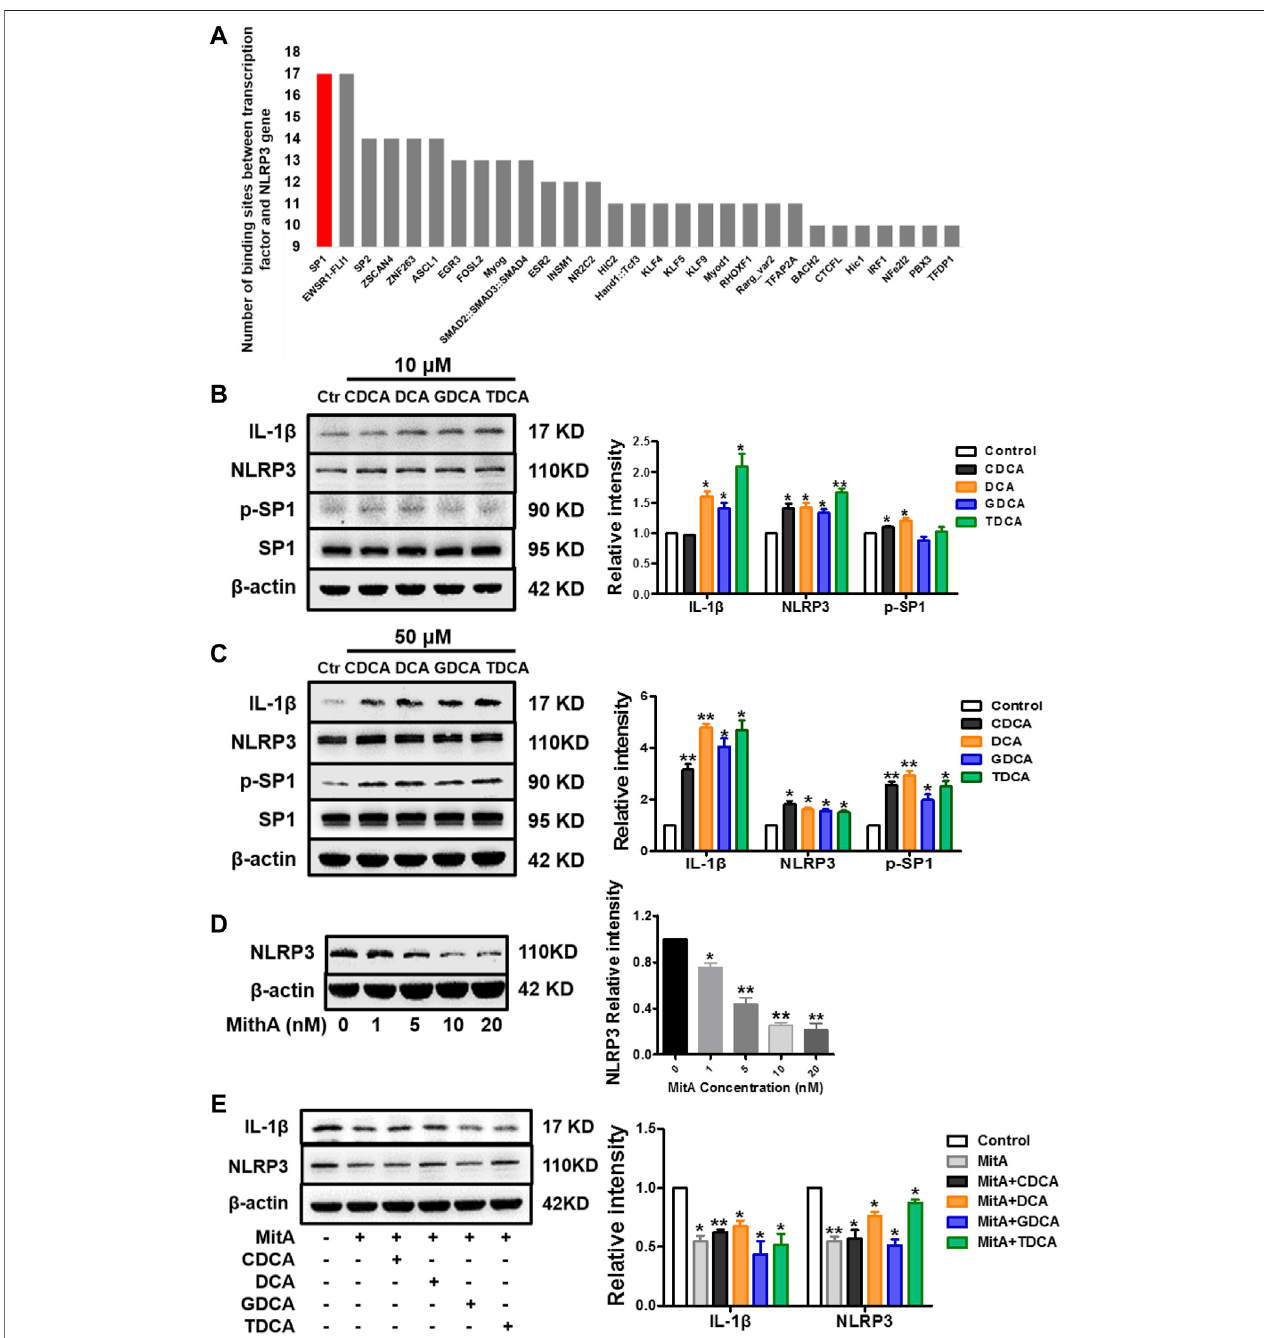
FIGURE 3 | SP1 mediates the activation of NLRP3 in fl ammasome in non-in fl ammatory conditions in macrophages. (A) Ranking of binding sites between different transcriptionfactors andNLRP3gene(datawerefromtheeukaryoticpromoterdatabase,from − 2,000to100 bprelativetoTSS,andthecut-offwas p =0.001)(https:// epd.ep fl .ch).WesternblotanalysisofIL-1 β ,NLRP3,andSP1inmacrophagesdifferentiatedfromTHP-1monocyteswith (B) 10 μ Mand (C) 50 μ MBAtreatmentsfor4 h. (D) NLRP3 expression analyzed by Western blot with different concentrations of MitA for 48 h. (E) Western blot analysis of IL-1 β and NLRP3 after cells